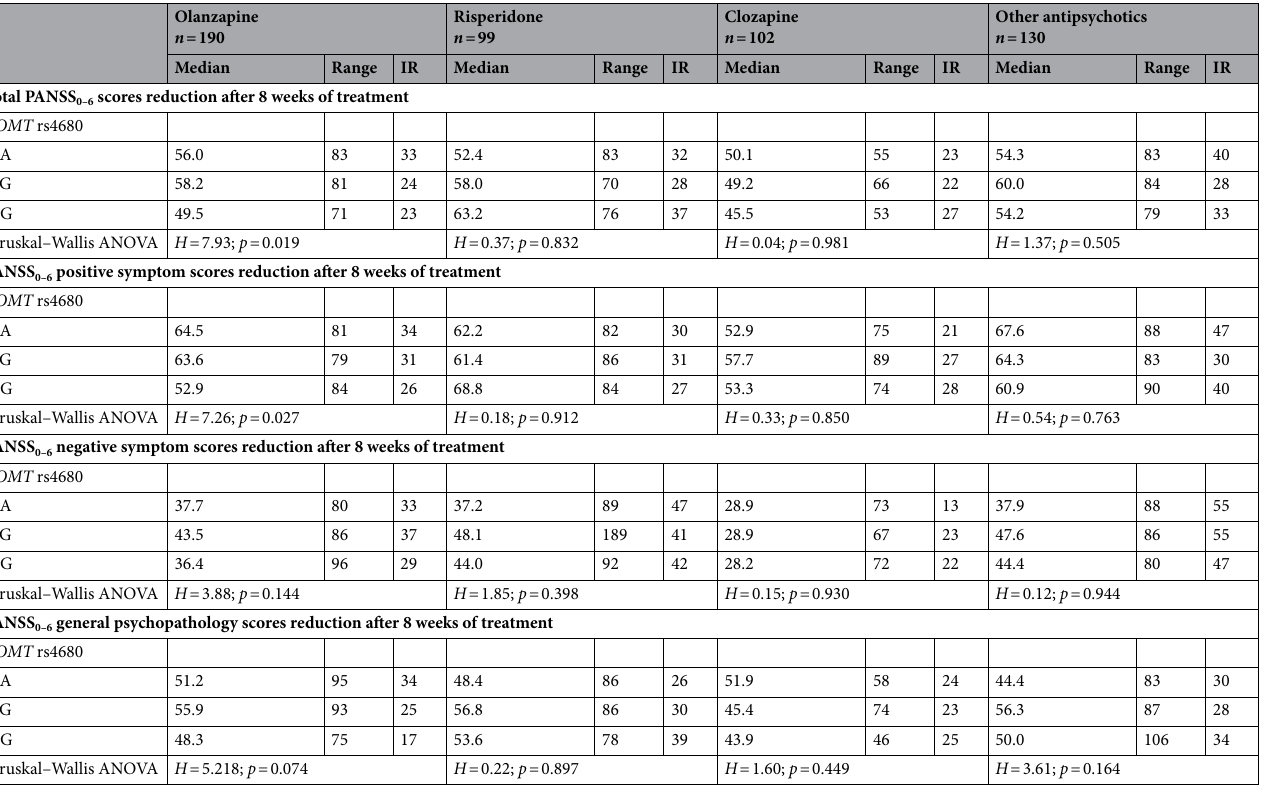
Table 5. Percentage of reduction from the initial PANSS 0–6 total and subscale scores after 8 weeks of treatment with olanzapine, risperidone, clozapine or other antipsychotics in schizophrenia patients subdivided according to the COMT rs4680 genotypes. Values are given as median, range and interquartile range (IR). n number of subjects, PANSS positive and negative syndrome